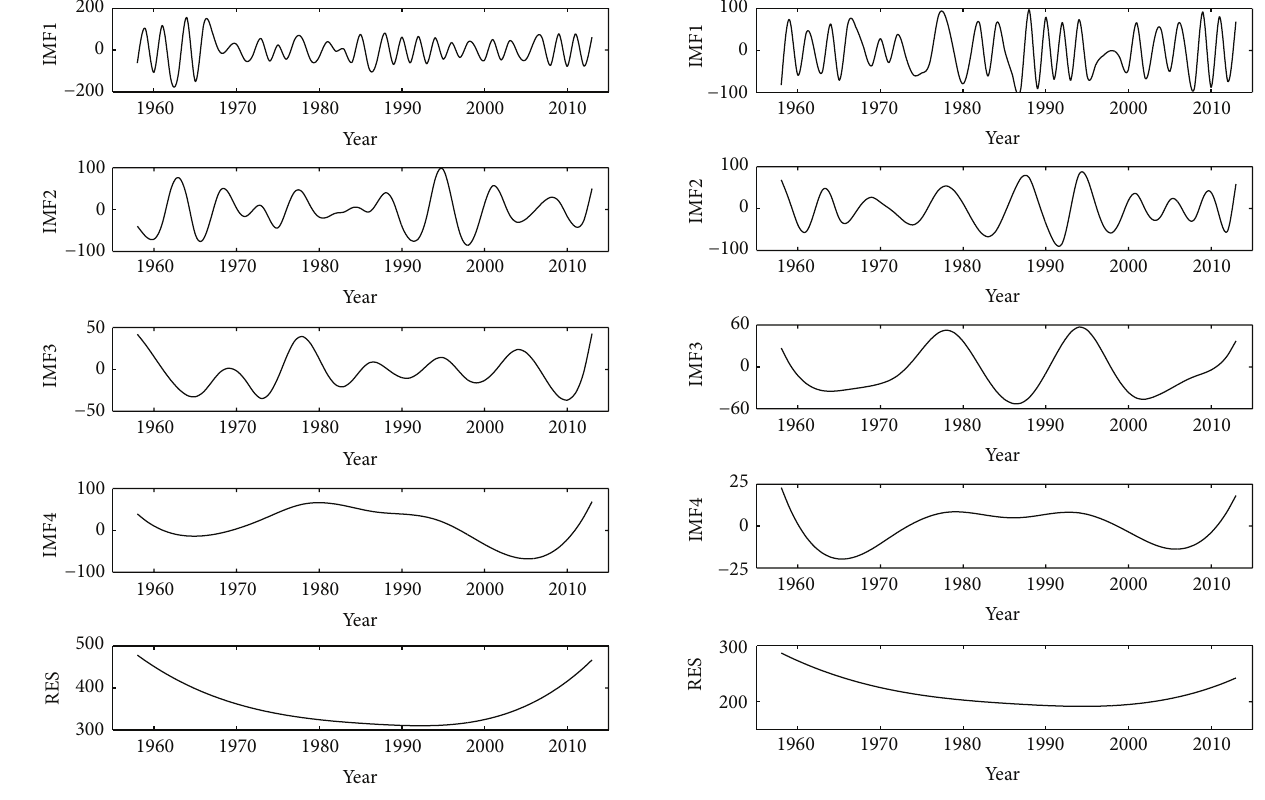
Figure 4: EEMD of the 𝑃 𝑓 time series from 1958 to 2013 at the Suide station.